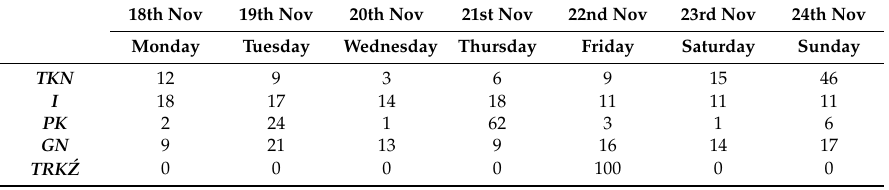
Table 13. Reactions of Internet users on particular days of posting on FB (%).